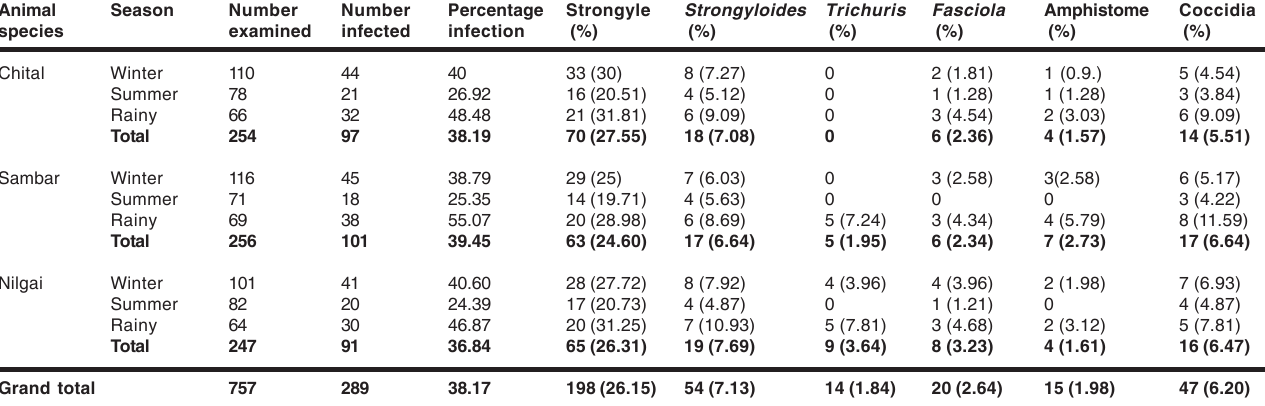
Table 1. Prevalence of parasitic infection in free ranging herbivores Animal